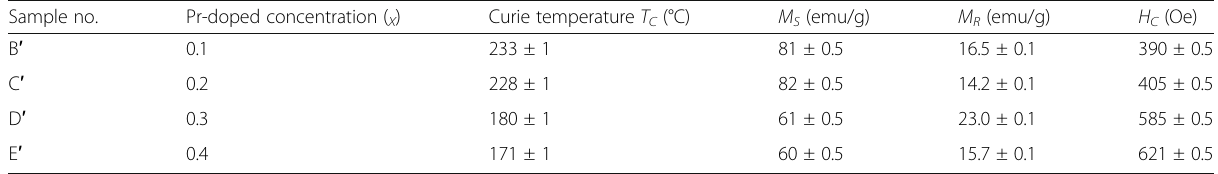
Table 3 The Curie temperature ( T c ), saturation magnetization ( M S ), remanent magnetization ( M R ), and coercive field ( H C ) of